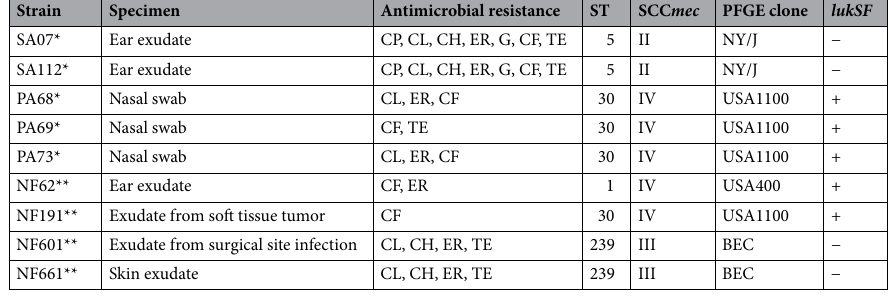
Table 1. Antimicrobial resistance and molecular characterization of the MRSA isolates collected from canines. CP ciprofloxacin, CL clindamycin, CH chloramphenicol, ER erythromycin, G gentamicin, CF cefoxitin,